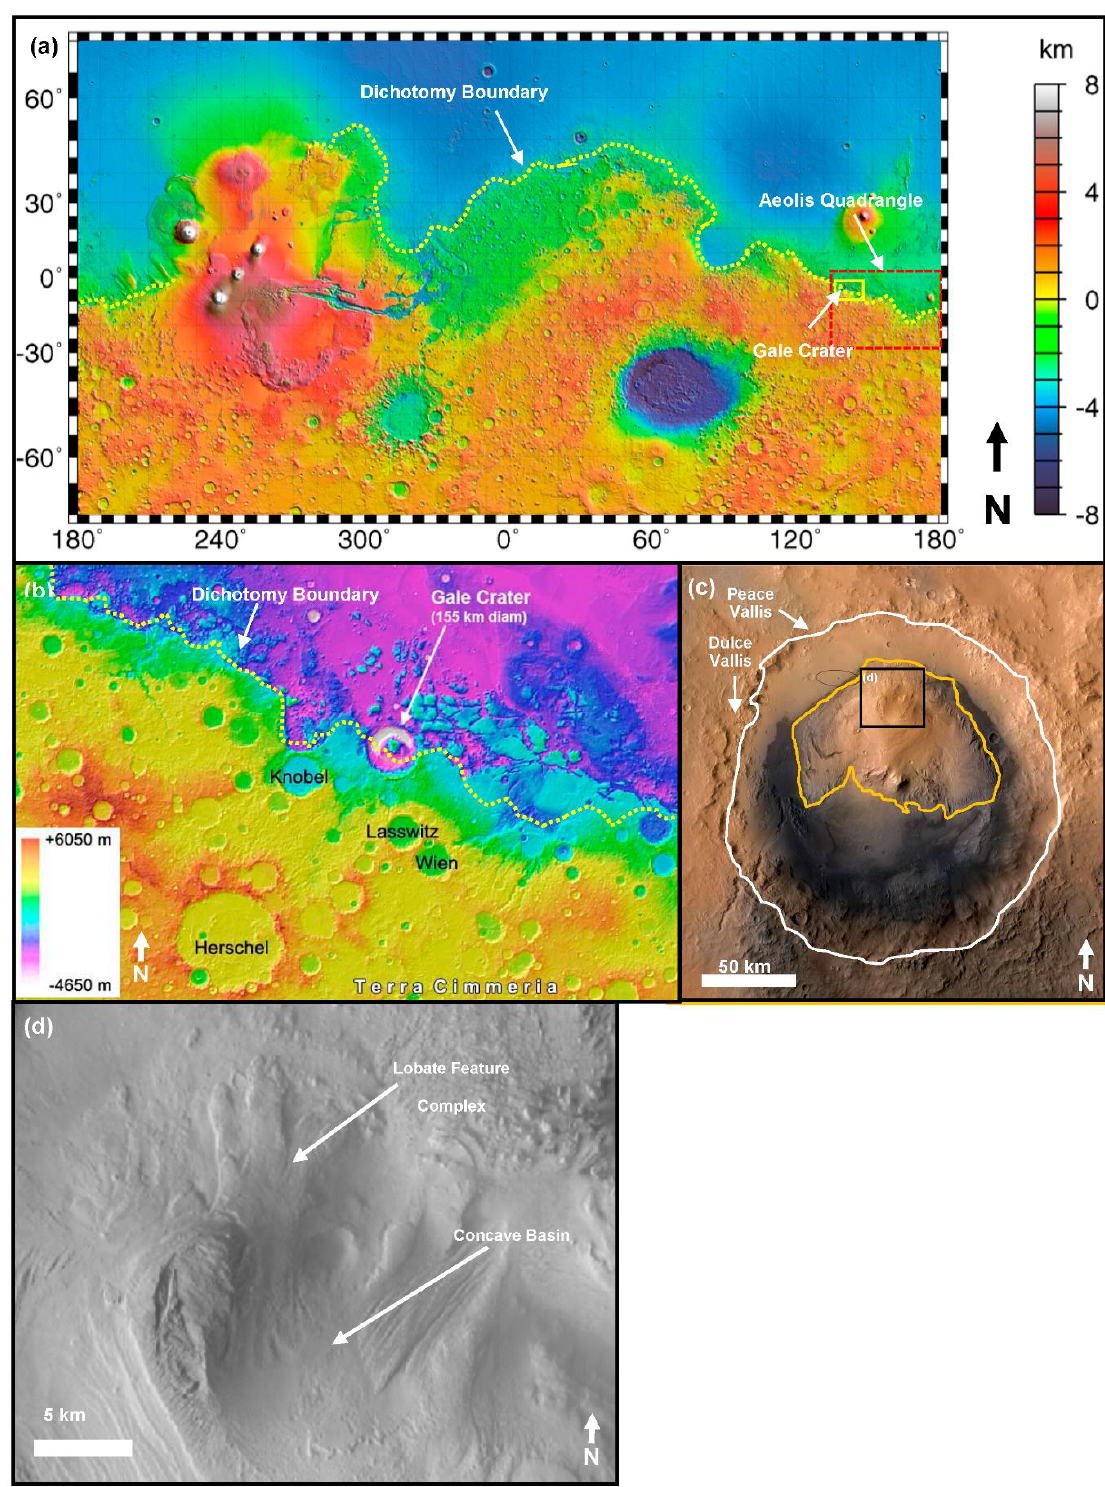
Figure 1. ( a ) Mars MGS MOLA Global Color Shaded Relief 463 m/pixel context map; ( b ) inset (yellow box) showing location of Gale crater and dichotomy boundary in the northwest portion of the Aeolis Quadrangle (red dashed box); ( c ) HRSC DEM combined with CTX image data and Viking Orbiter imagery. White: outline of Gale crater, yellow: outline of Mount Sharp. Brown oval: MSL landing ellipse; ( d ) HRSC image mosaic of the lobate feature complex and concave basin. Photo credit: NASA/JPL-Caltech/ESA/DLR/FU Berlin; Williams, J. M.